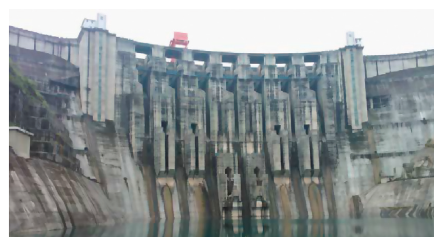
Figure 2: Photograph of the main body of the dam.